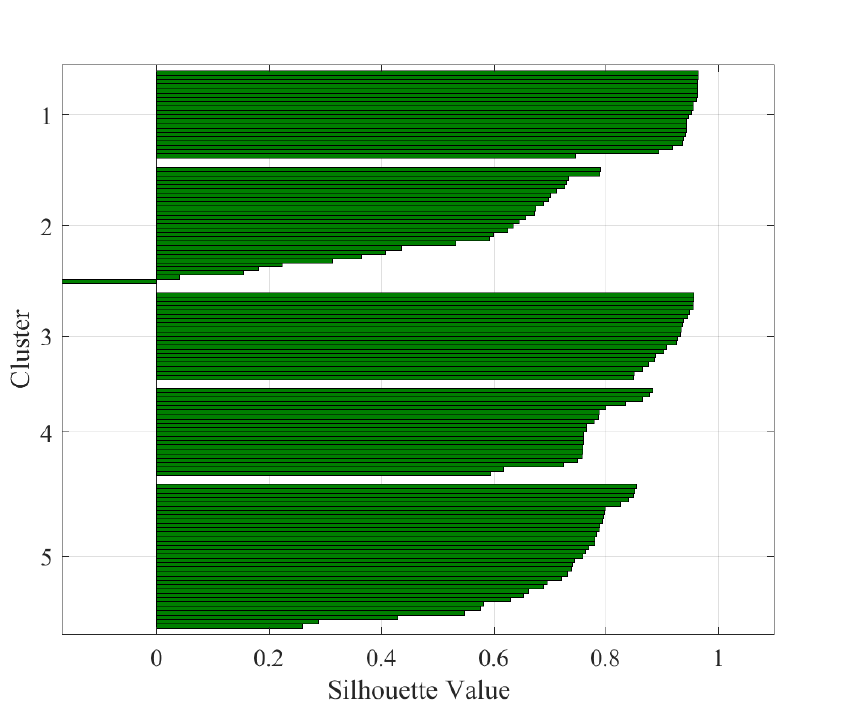
Figure 12. Silhouette plot of clustered stator current harmonics data with k =